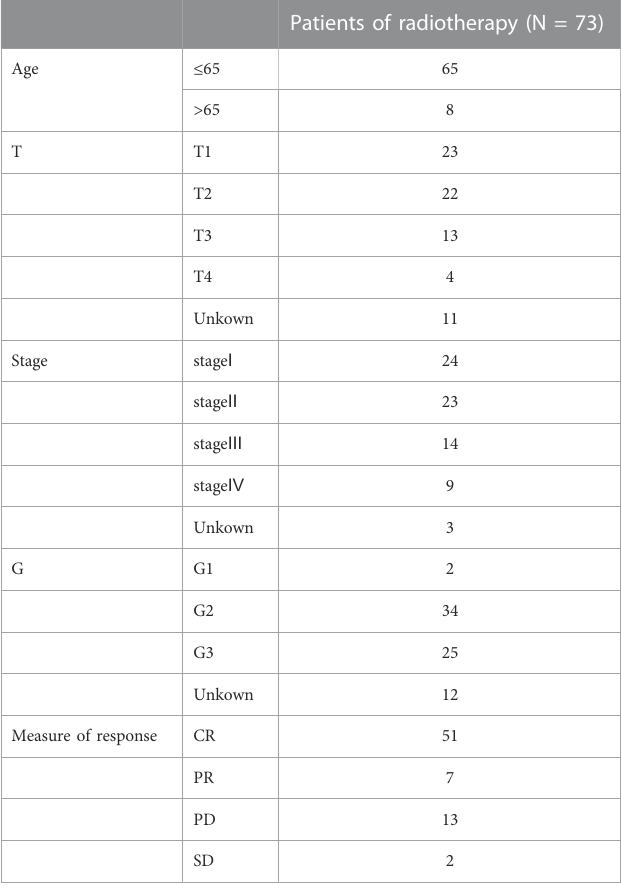
TABLE 3 Clinical characteristics of patients who received radiotherapy and had complete radiotherapy